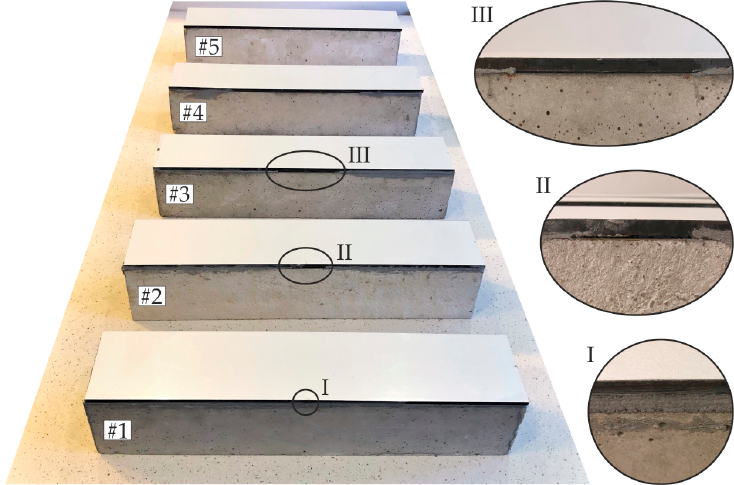
Figure 2. Photograph of prepared specimens (#1–#5) with close-up views of adhesive films in beams #1, #2, and #3.